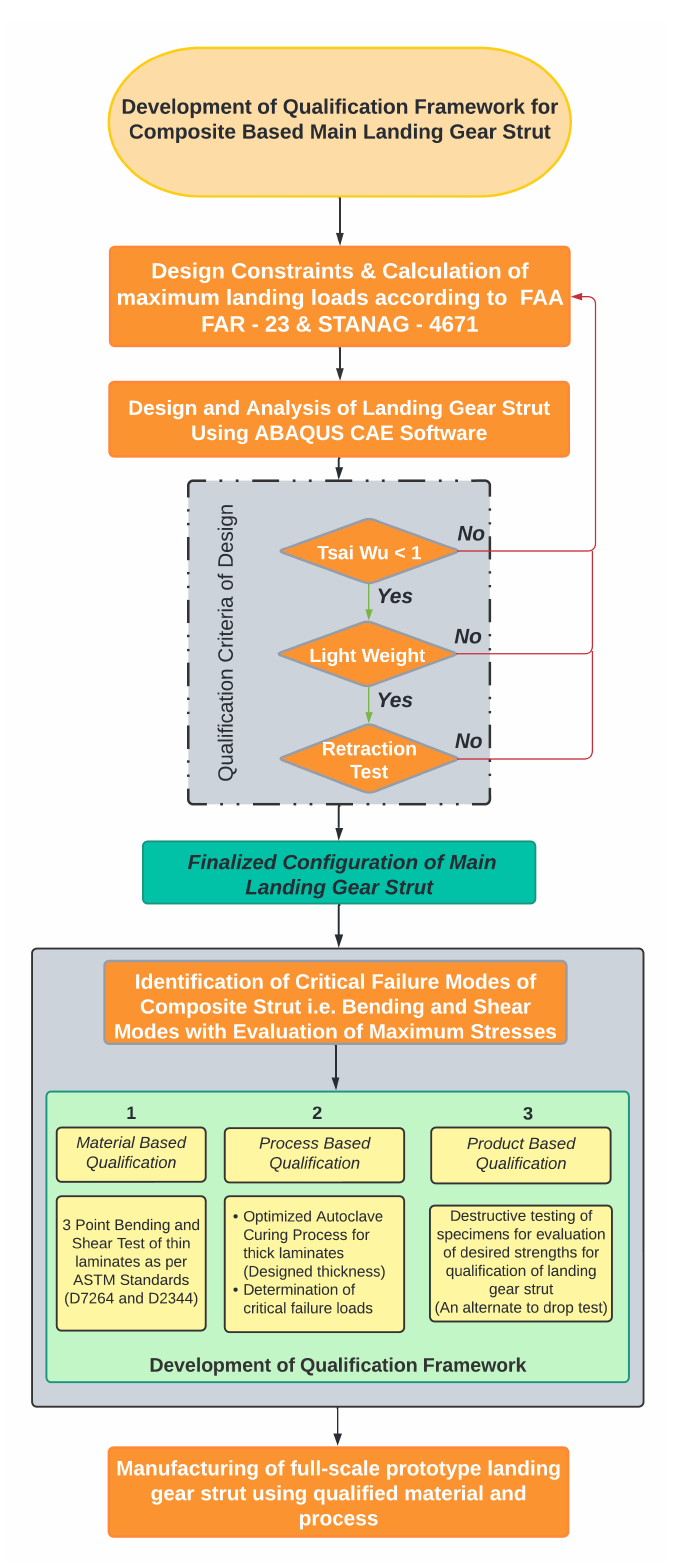
Figure 1. Proposed methodology for development of qualification framework for composite-based main landing gear